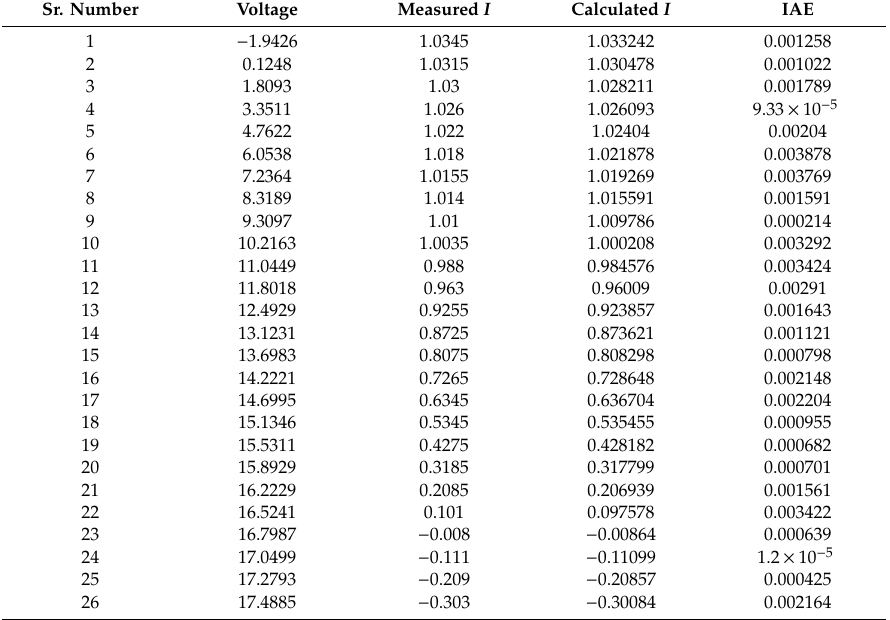
Table 9. I–V values and the relative IAE for the single-diode module.